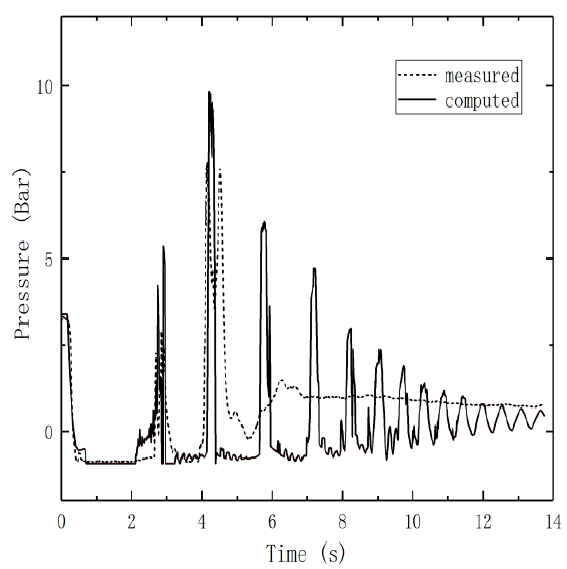
Figure 4. Comparison of measured and simulated pressures at the Number 1 measurement point after optimization.